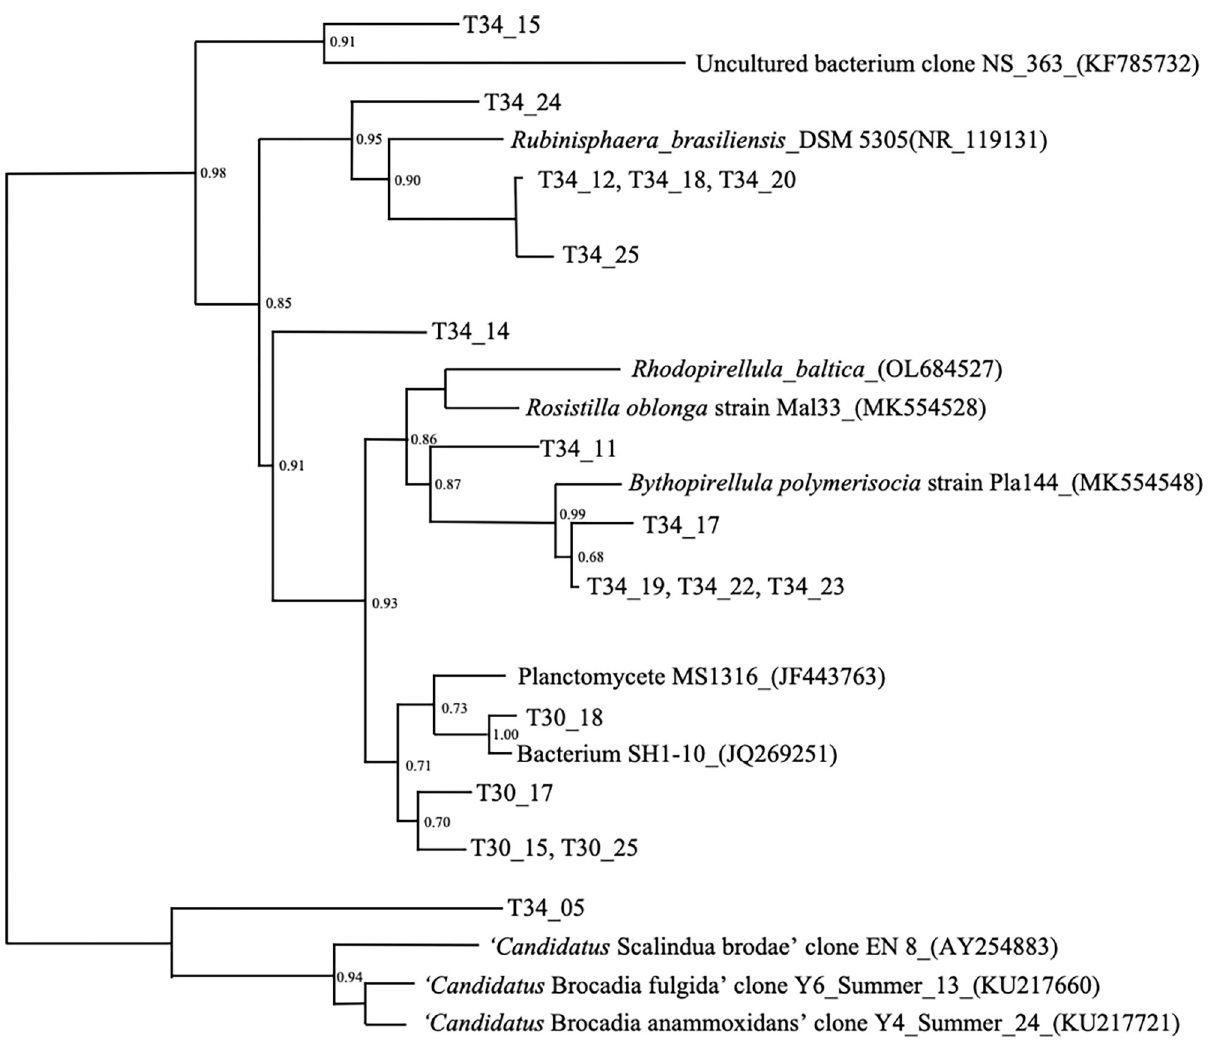
Fig 5. Maximum likelihood phylogenetic tree of aquarium-derived ribosomal 16S rRNA genes. Sequences were identified within marine temperate (T30) and marine cold (T34) sand filter samples. Reference sequences of bacteria belonging to the Planctomycete phylum are included with GenBank numbers provided in parentheses. Numbers at tree nodes represent bootstrap support values from 1000 replications. Only those values above 0.50 are represented. E . coli strain JNQH497 (CP091925) was used as an outgroup.